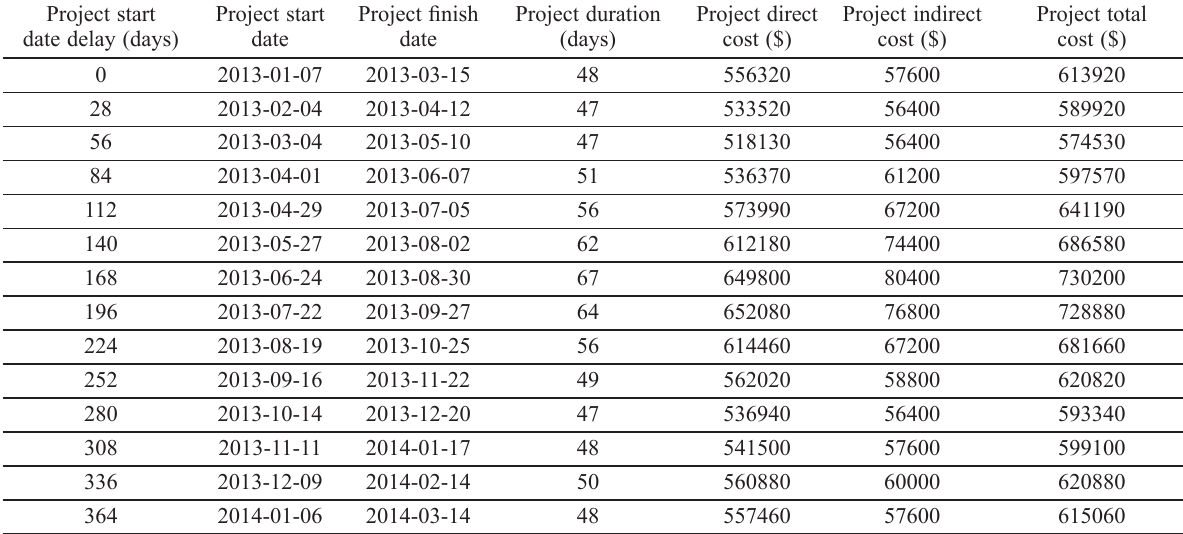
Table 1. Project costs